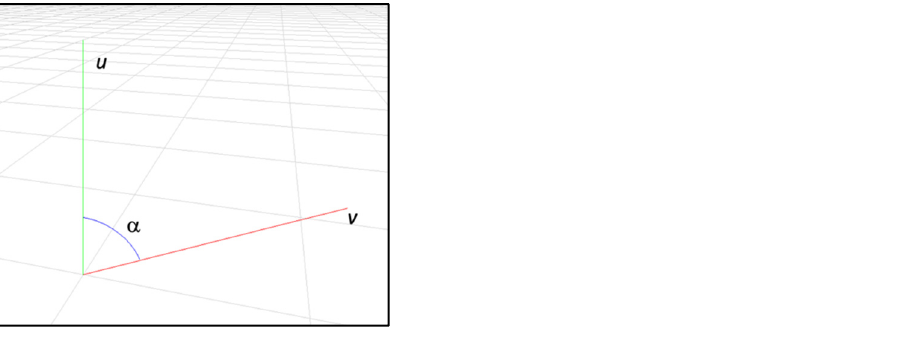
Figure 5. The angle between two 3D vectors representing two skeleton keypoints forming a joint.